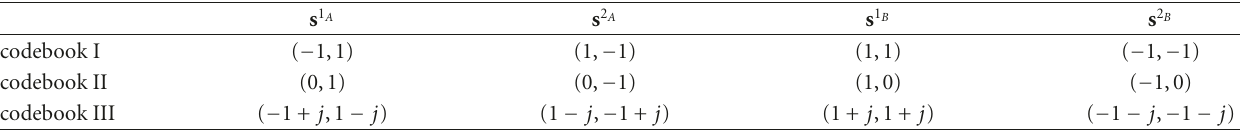
Figure 7: The sign of parameter α a ff ects only the hierarchical codewords pattern, not the shape of the HDFD decision regions. Table 2: Example binary E-PHXC codebooks.